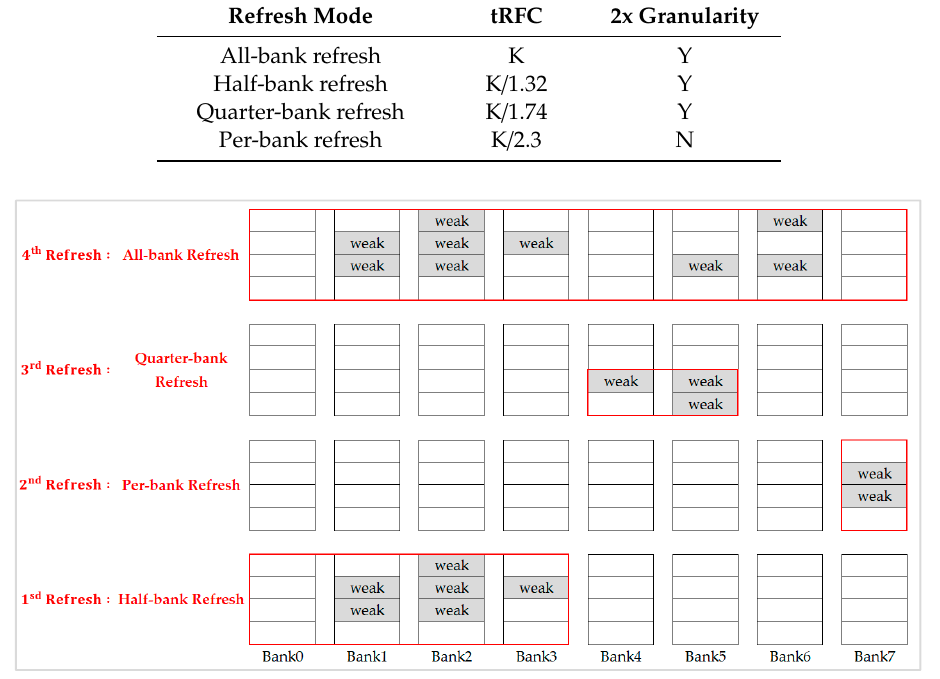
Figure 9. Integration refresh scheme in each refresh.